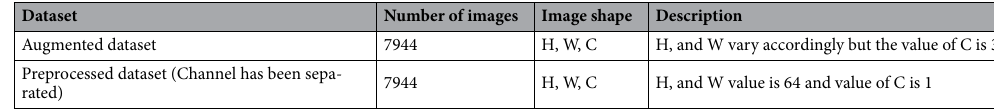
Table 4. Dataset after